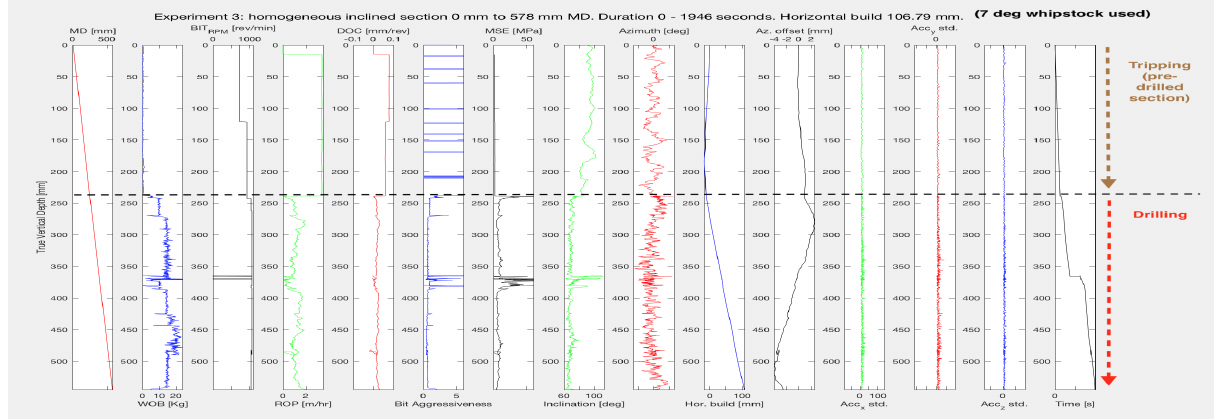
Figure 8: Experiment 3: Well log representing rig performance when RIH to 240 mmTVD and then drilling with downhole motor to 600 mmTVD. A 7 degrees whipstock is used to kick